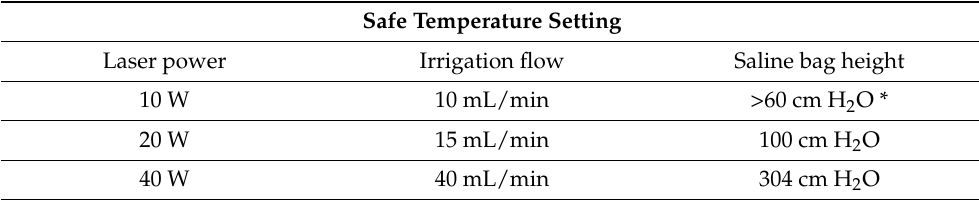
Table 3. Safe temperature settings during